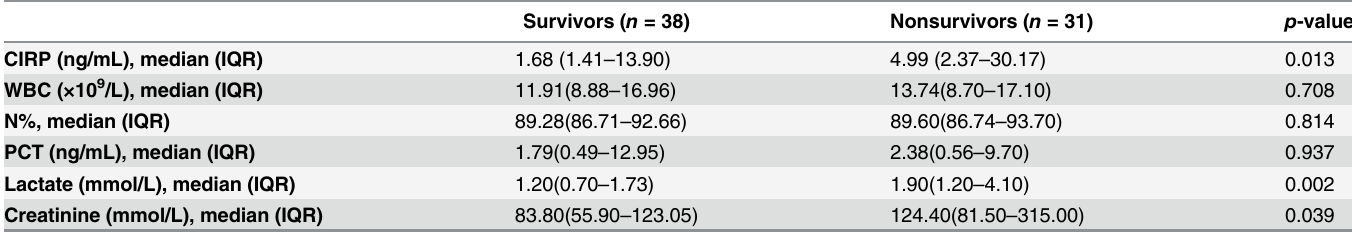
Table 2. Comparison of the plasma biomarker levels between the survivors and nonsurvivors of